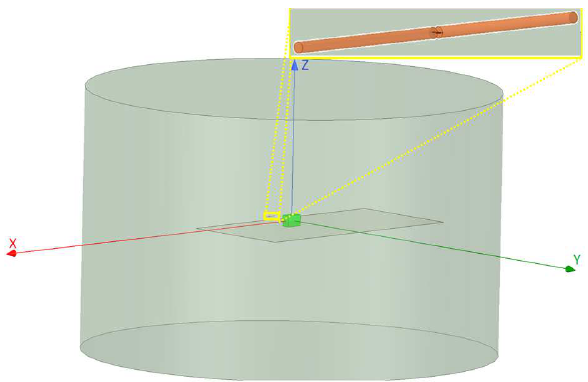
Figure A4. Configuration II in which a horizontal dipole antenna replaces the Bessel beam launcher for Case